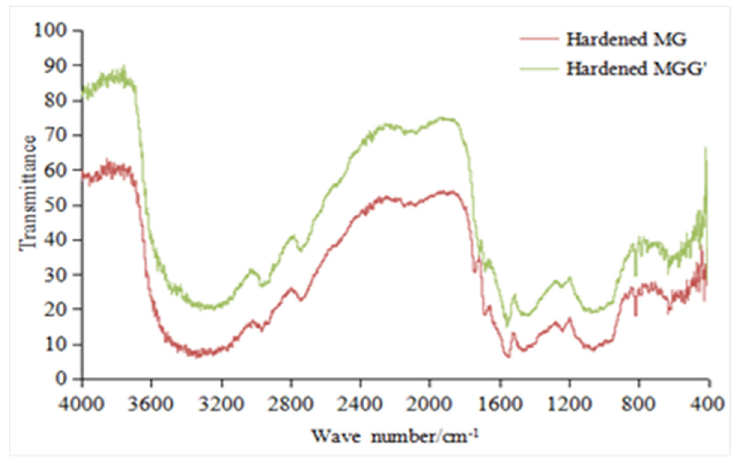
Table 7. FTIR spectra of hardened MG and MGG’ resins.